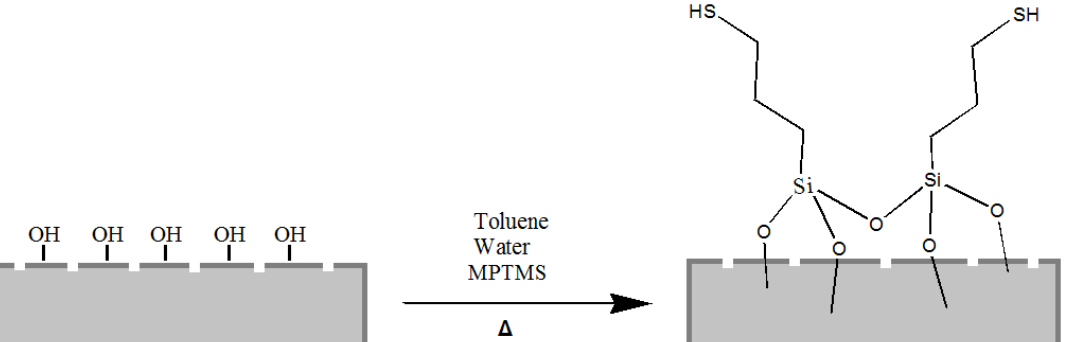
Figure 3. Scheme of diatom frustule passivation with 3-mercaptopropyl-trimethoxysilane (MPTMS).